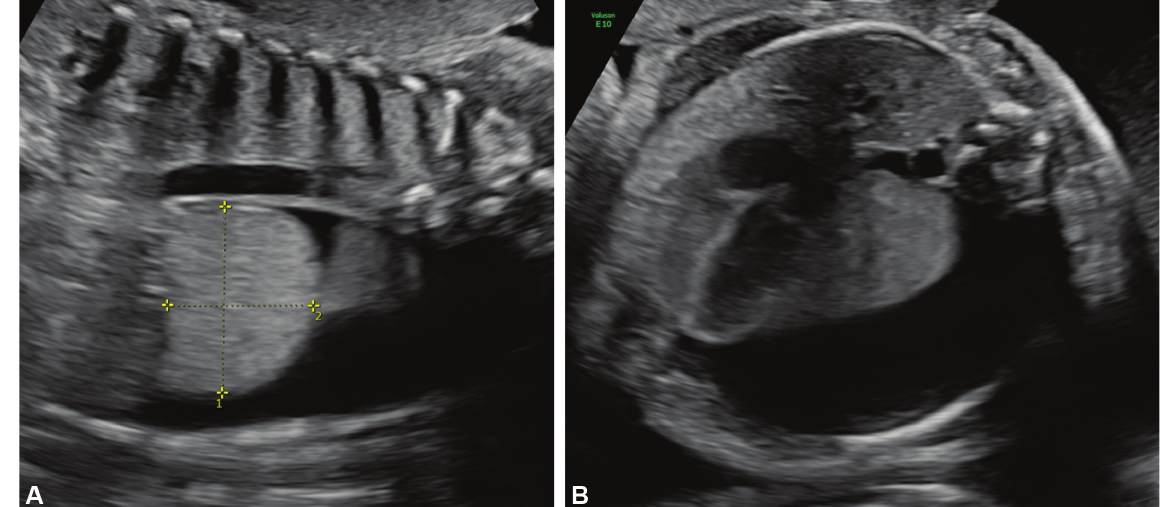
Fig. 1 Prenatal images of patient described as case 1. Sagittal view of the echogenic mass in the inferior portion of the left fetal lung ( A ) and transverse view showing severe unilateral hydrothorax ( B